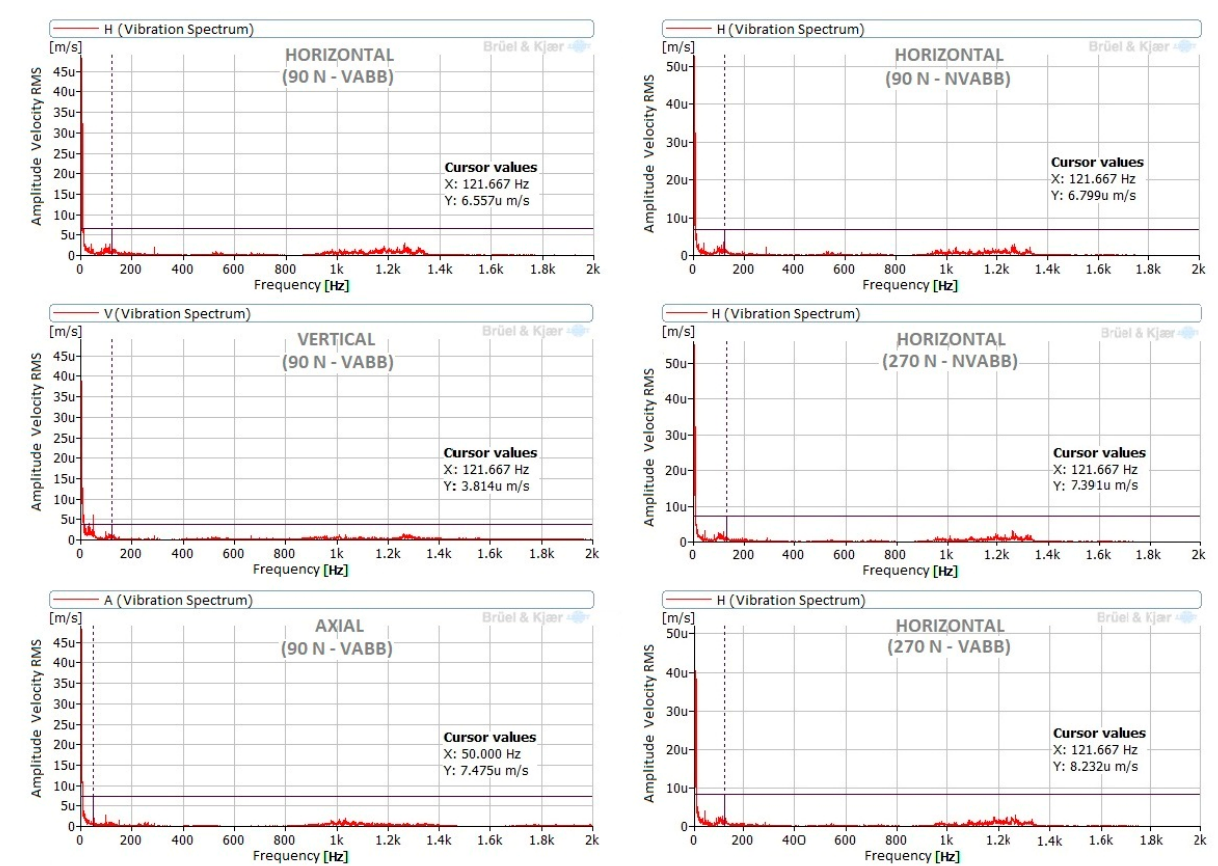
Figure 12. Spectra measured in lathe test bed at different loads and different measurement positions.